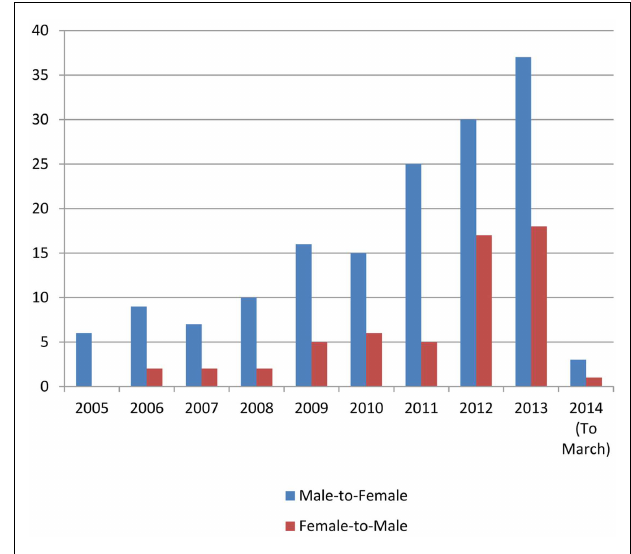
FIGURE 1 | Number of referrals per year.